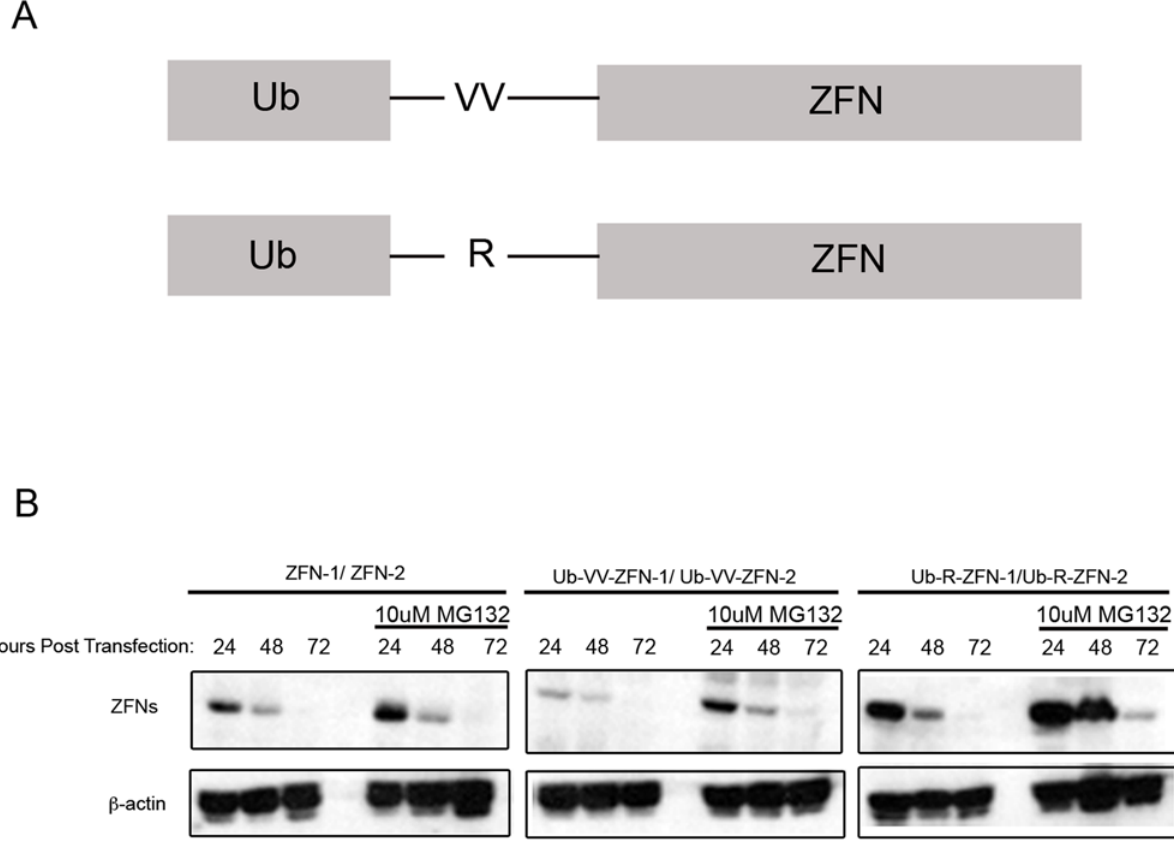
Figure 1. Characterization of Ub-X-ZFNs that display drug-dependent stability. (A) Genetic fusion of a ubiquitin moiety to a ZFN with either a ‘‘VV’’ linker or an ‘‘R’’ linker. (B) Expression profile of unmodified and Ub-X-ZFN proteins in the presence and absence of 10 uM of the proteasome inhibitor MG132 from 18–22 hours post-transfection. HEK 293FT cells were transiently transfected with vectors encoding either ZFN-1/ ZFN-2, Ub-VV-ZFN-1/-2, or UB-R-ZFN-1/ZFN-2. ZFNs were detected using Western blot analysis with an anti-Flag antibody. ZFN-1/ZFN-2 and Ub-R- ZFN-1/ZFN-2 were approximately 37 kD and Ub-VV-ZFN-1/ZFN-2 were approximately 47 kD. The size difference between the Ub-X-ZFNs is due to the Ub-moiety being cleaved off when linked via an R-linker. b -actin serves as a loading control.